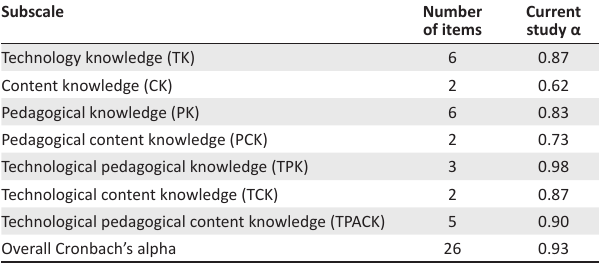
TABLE 2: Cronbach’s alpha coefficients for the seven knowledge domains of the TPACK questionnaire.